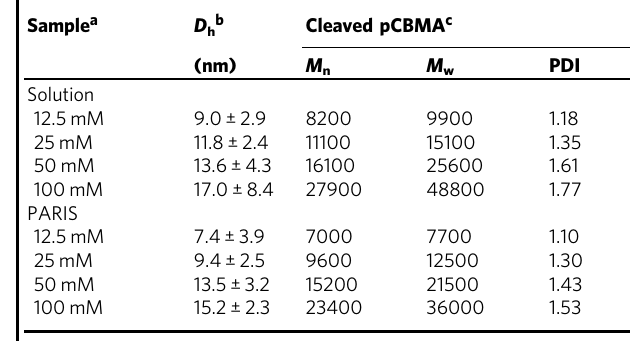
Table 4 PARIS and solution-based conjugate ATRP